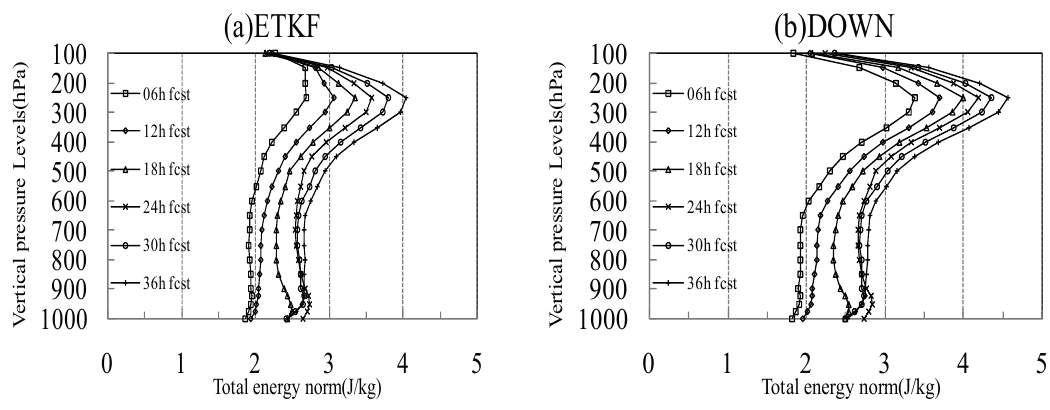
Figure 4. Vertical distributions of ensemble mean total energy (unit: J/kg), different lines denote different forecast lead times. ( a ) ETKF; ( b )